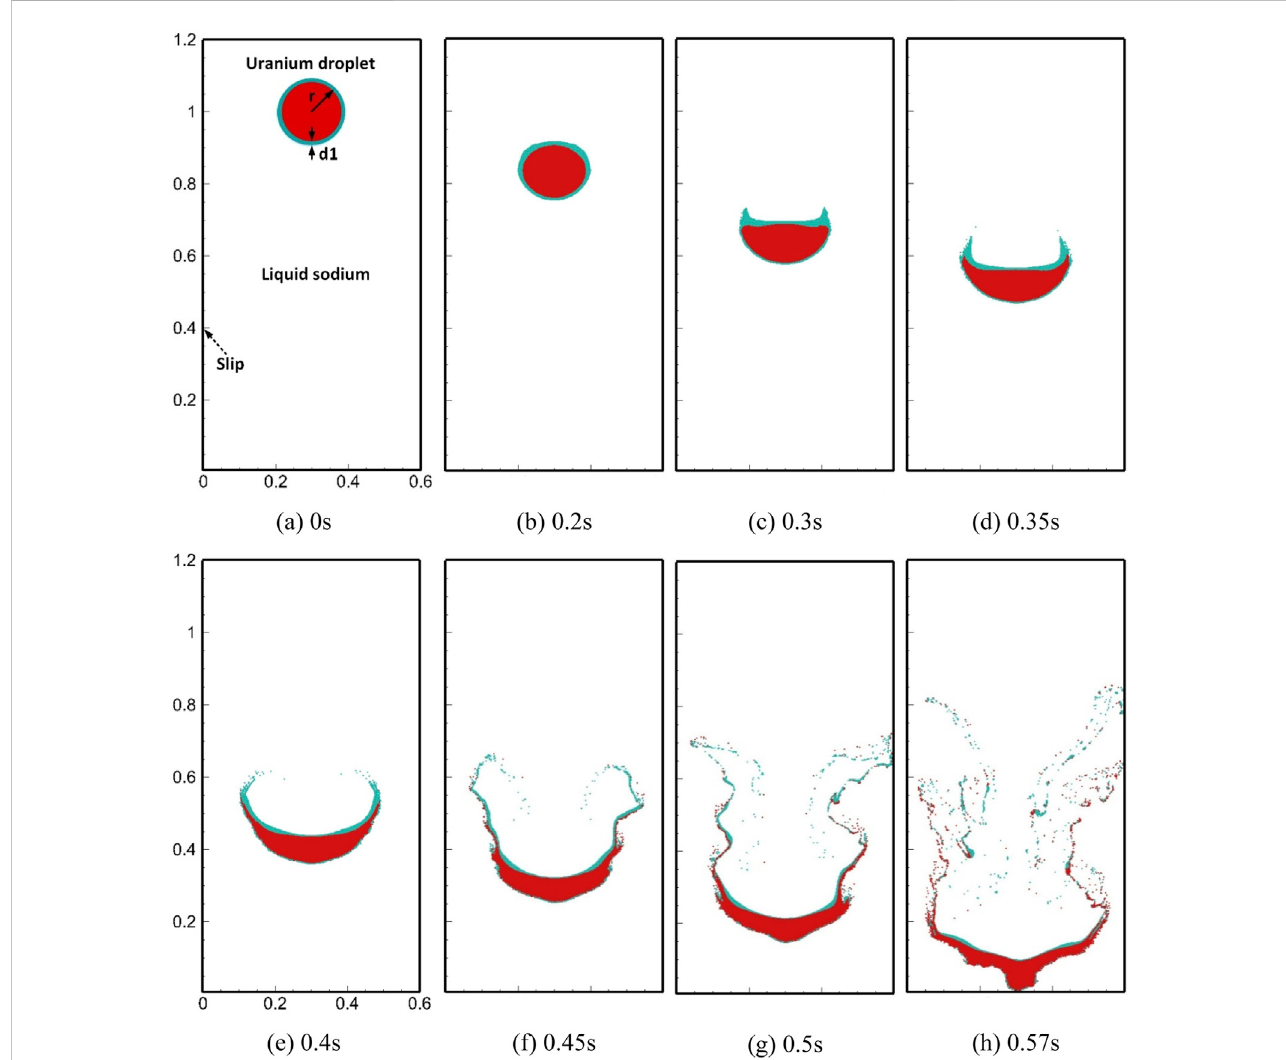
FIGURE 11 Initial setup and images in the interaction between U coated with Stainless steel fi lm with thickness of 0.01 m and